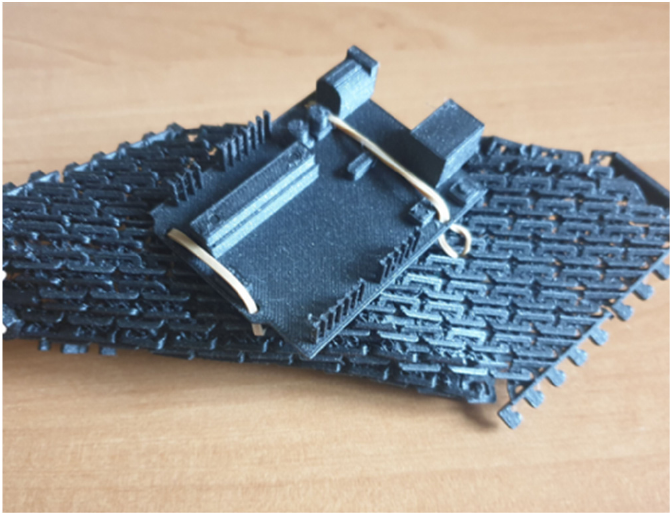
Figure 10. Possibilities of prepared chainmail for hand exoskeleton folding.